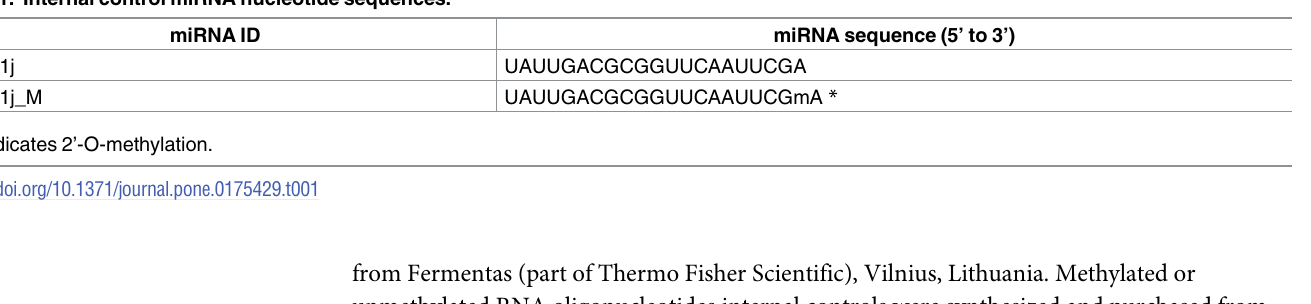
from Fermentas (part of Thermo Fisher Scientific), Vilnius, Lithuania. Methylated or